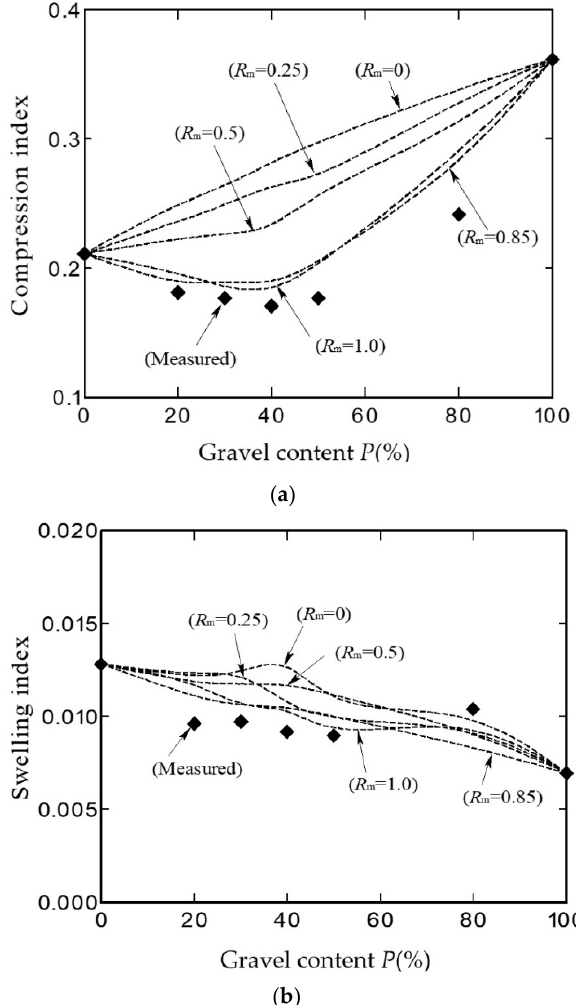
Figure 7. Relationship between gravel content and material constant: ( a ) compression index ( λ ); ( b ) swelling index ( κ ).